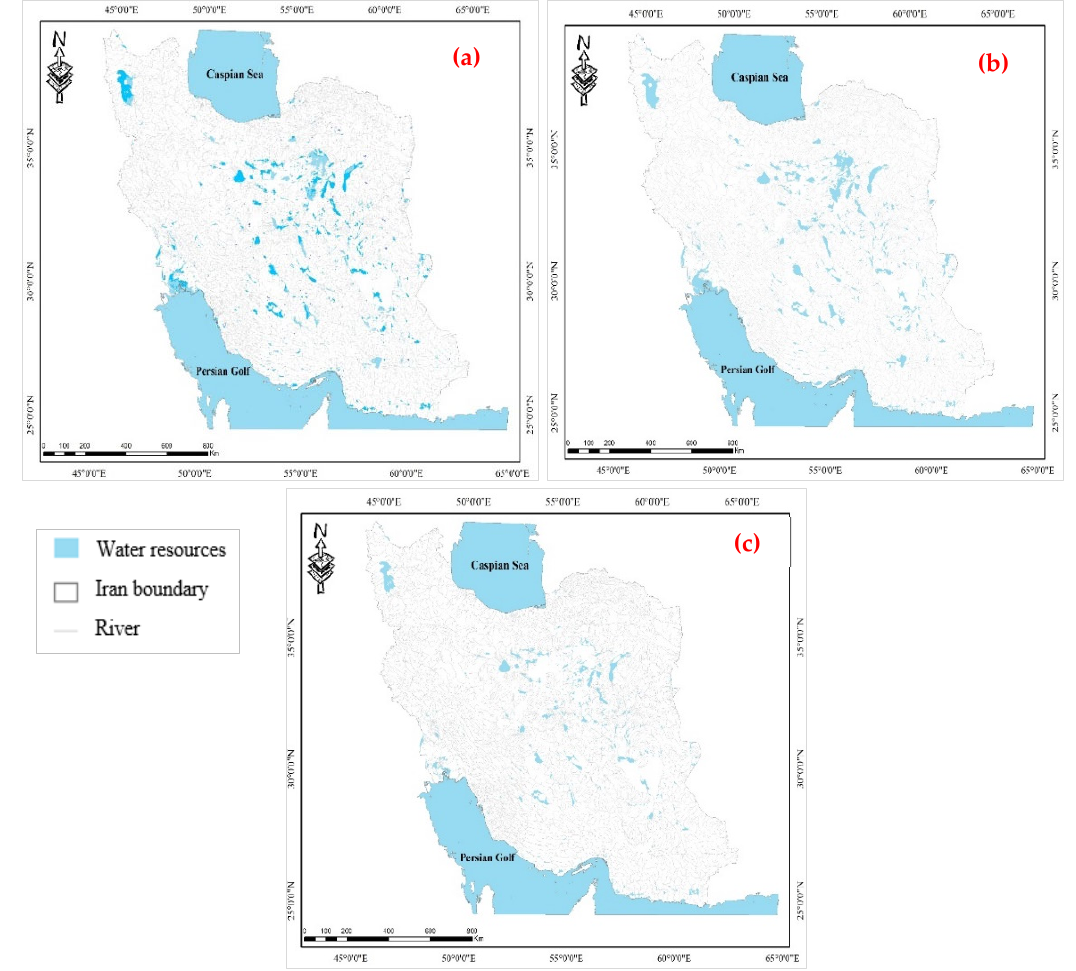
Figure 2. Changes in water resources in Iran: ( a ) 1990, ( b ) 2009, and ( c ) 2021. Table 2. Changes in water resources in the studied basins in Iran from 1990 to 2021.